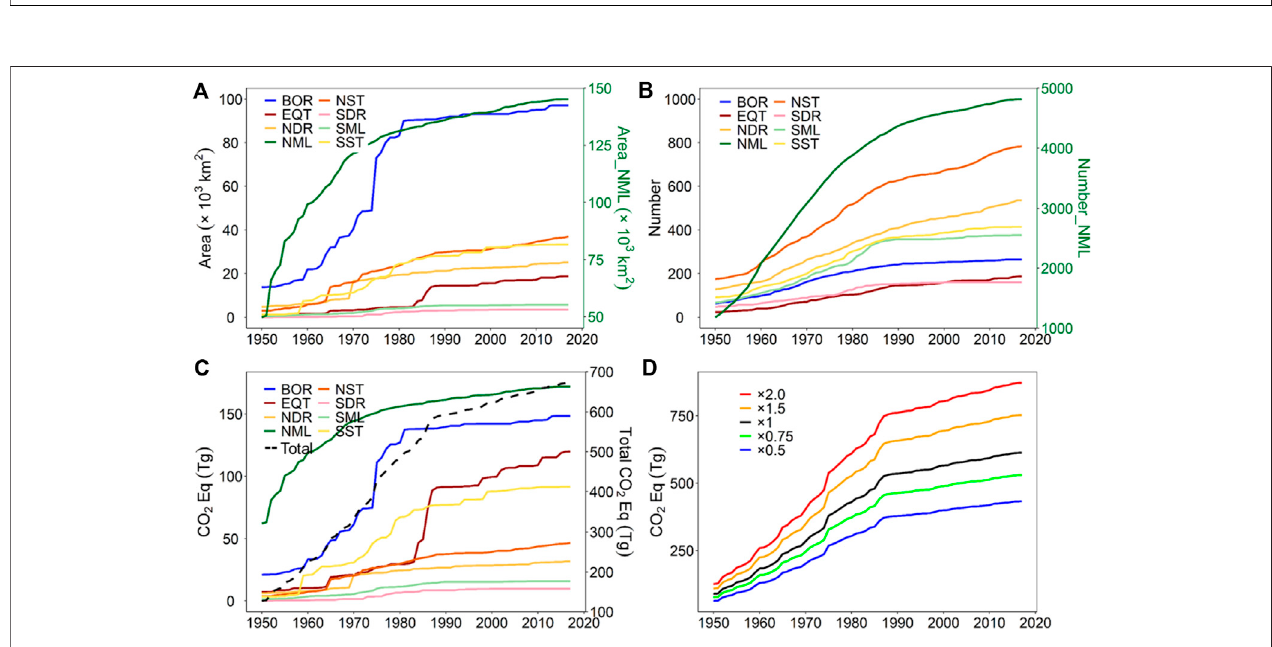
FIGURE 4 | Linear regressions for the relationships between CH 4 and CO 2 , and terrestrial net primary production (NPP) and precipitation in the reservoir catchments.